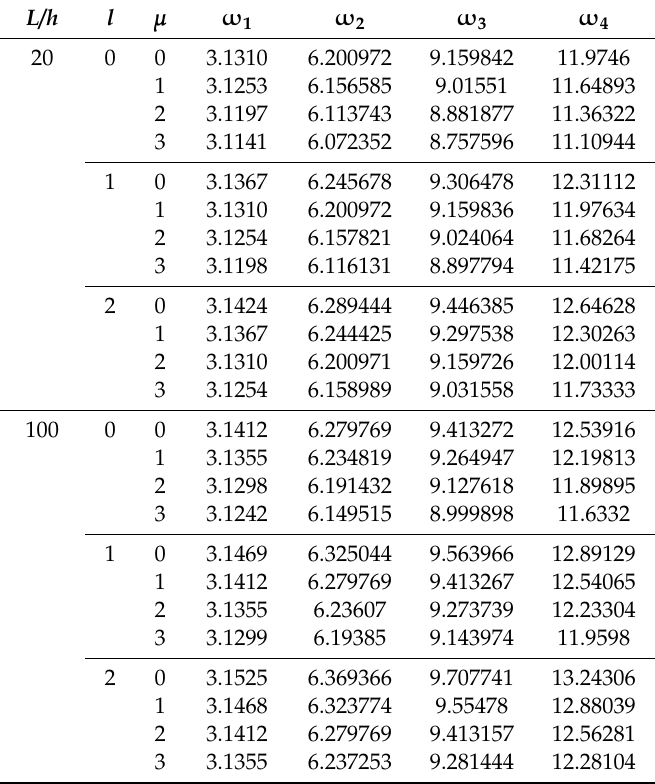
Table 4. E ff ect of the L / h and small-scale parameters on the natural frequencies for a simply-simply supported triclinic